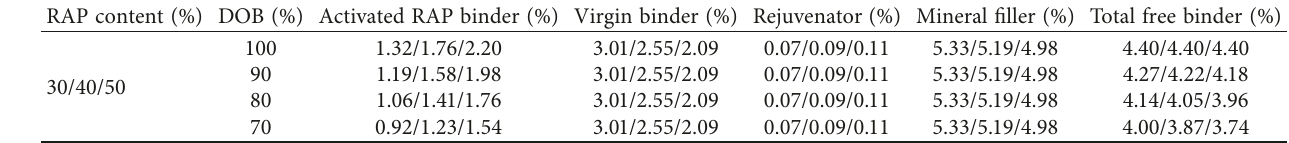
Table 11: Composition of mastic.